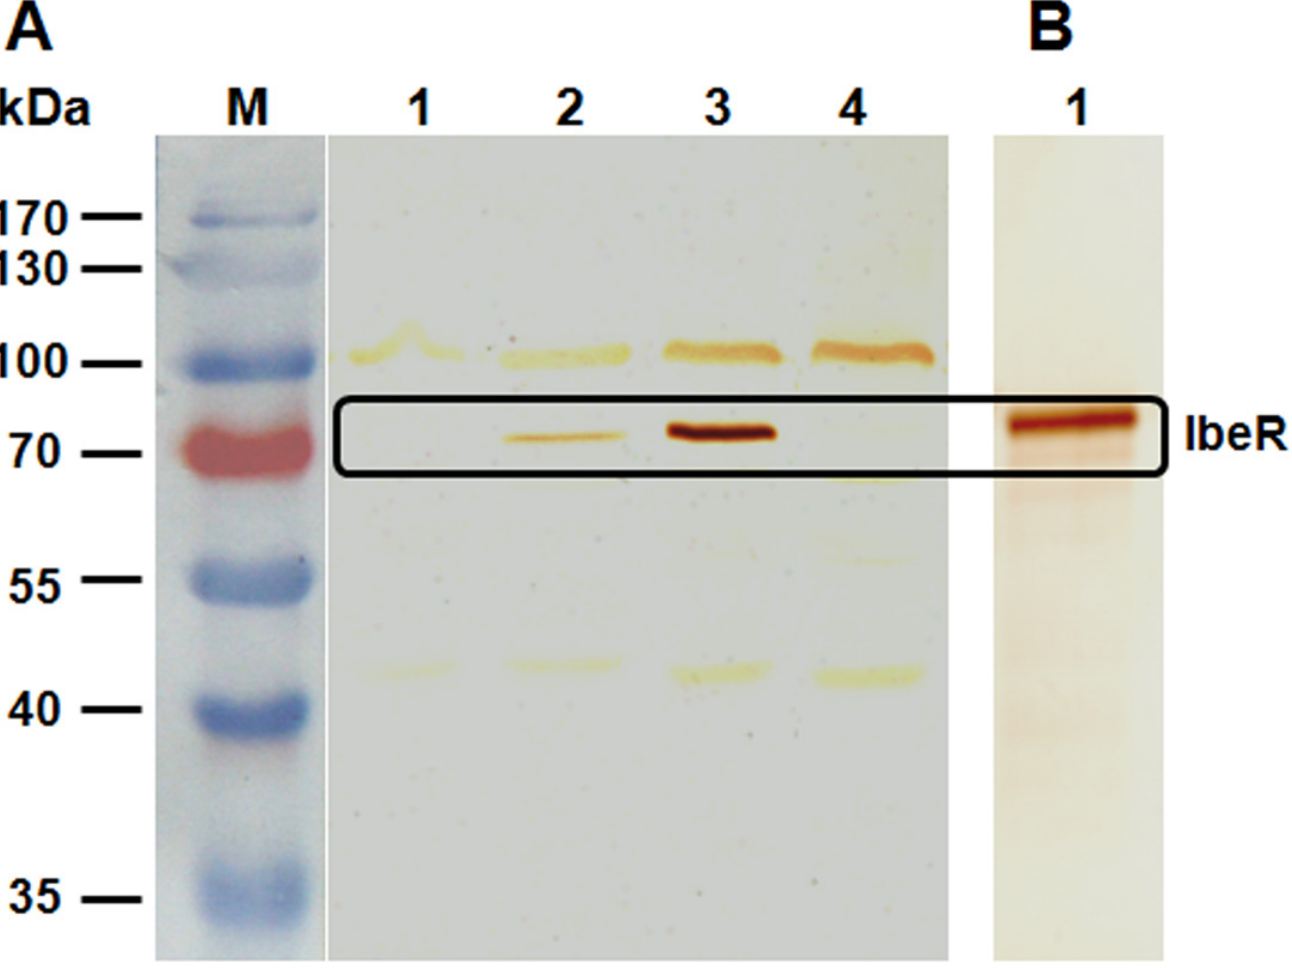
Fig 1. Expression of IbeR by Western blotting. (A) Immunoblotting with anti-IbeR of total cell lysates from different APEC strains. Expression of IbeR was detected in wild-type strain DE205B and complementation strain C Δ ibeR, but not mutant strains Δ ibeR or P Δ ibeR. Lane M, prestained protein marker; Lane 1, Δ ibeR ( ibeR negative); Lane 2, DE205B ( ibeR positive); Lane 3, C Δ ibeR ( ibeR positive); Lane 4, P Δ ibeR ( ibeR negative). (B) Immunoblotting of purified IbeR protein using anti-DE205B. Incubation with anti-DE205B detected protein bands of the expected size for purified IbeR protein. Lane 1,